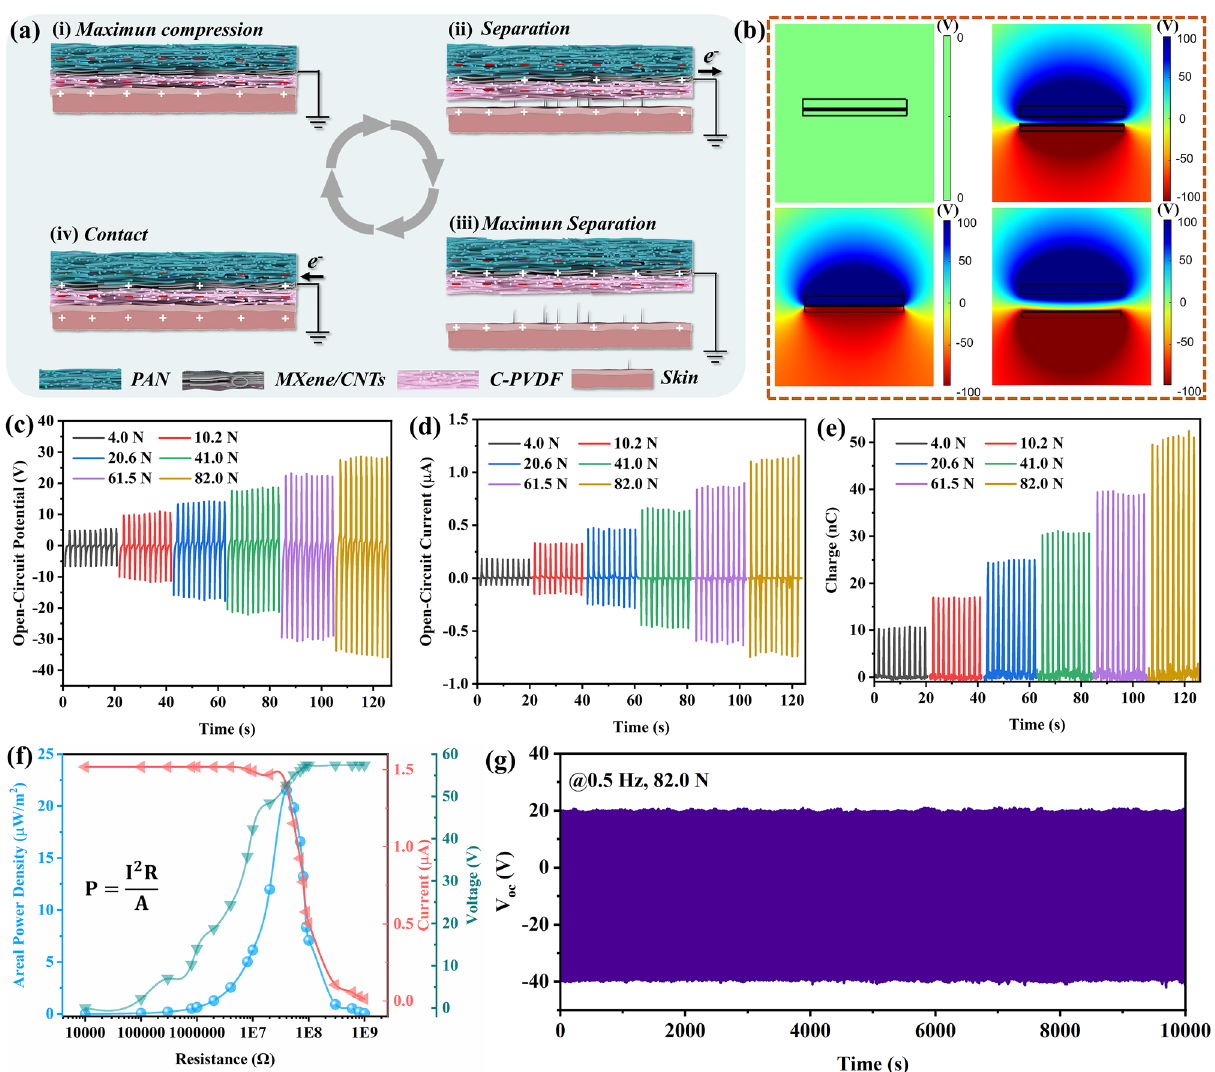
Fig. 5 Performance of the DMWES as STENG. a Schematic working principle of the DMWES under triboelectric sensing. b Numerical cal- culations of the potential distribution of the DMWES at the contact and separation states. c , d , e V OC , I SC , and Q SC of the TENG based on the DMWES under different forces. f Voltage and current, and areal power density of the DMWES at various external resistance loadings. g Cycling performance of continuous 5,000 cycles working of the